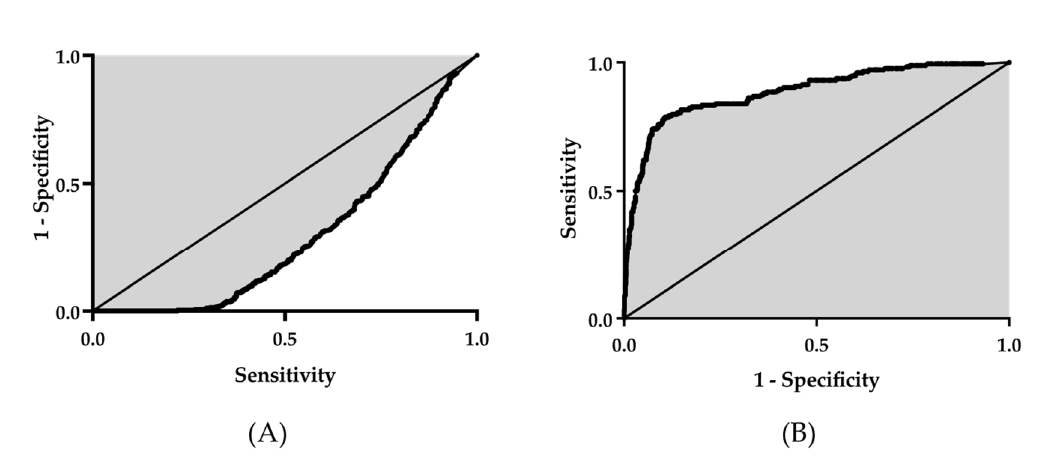
Figure 3. The ROC curve for predicting an ( A ) asymptomatic foot and ( B ) callosities by the MOD. The AUC was − 0.70 (95% CI [ − 0.67, − 0.73]) for an asymptomatic foot and 0.89 (95% CI [0.86–0.92]) for the prediction of callosities. ROC: receiver operating characteristic. AUC: area under the curve.